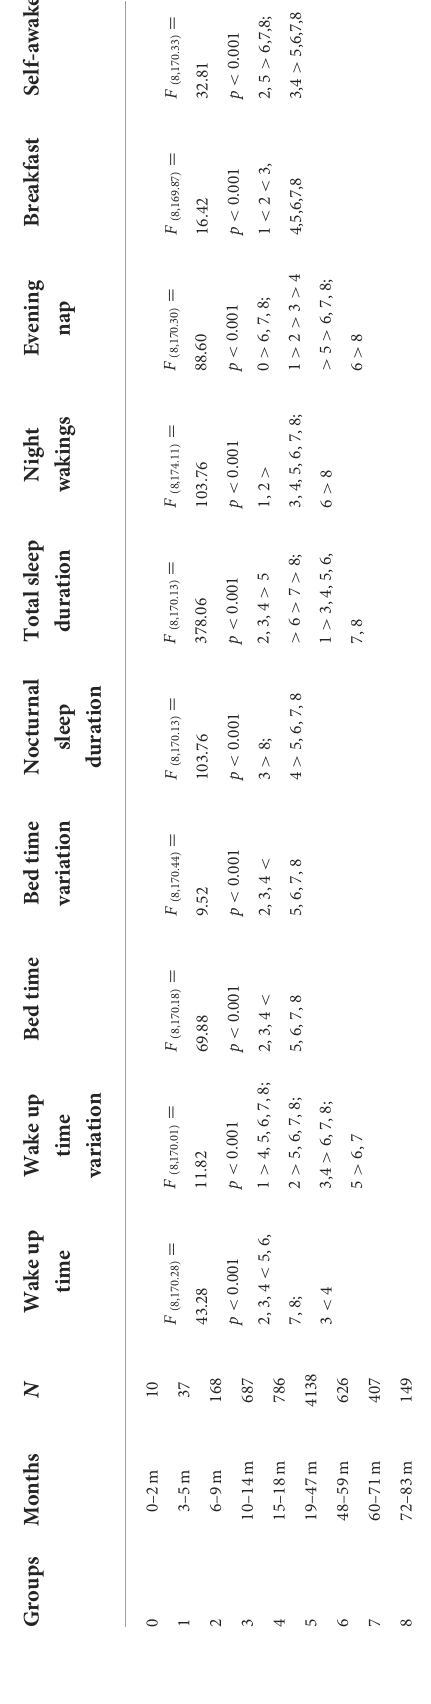
Descriptive statistics were calculated using SPSS version 27 software. The descriptive statistics for the 10 variables are presented in Table 1.